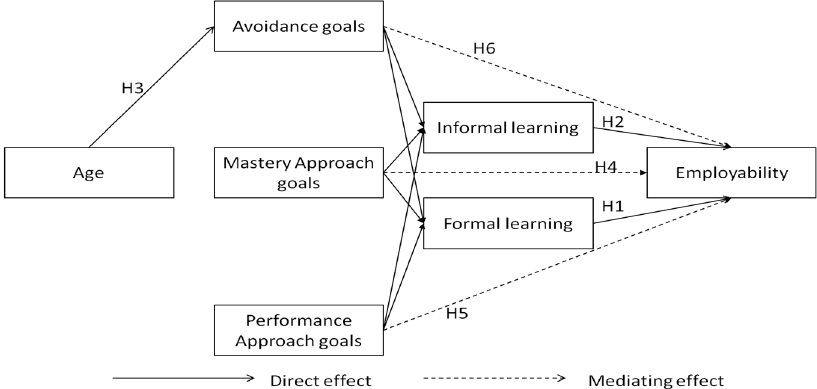
Figure 1. Overview of the research model.